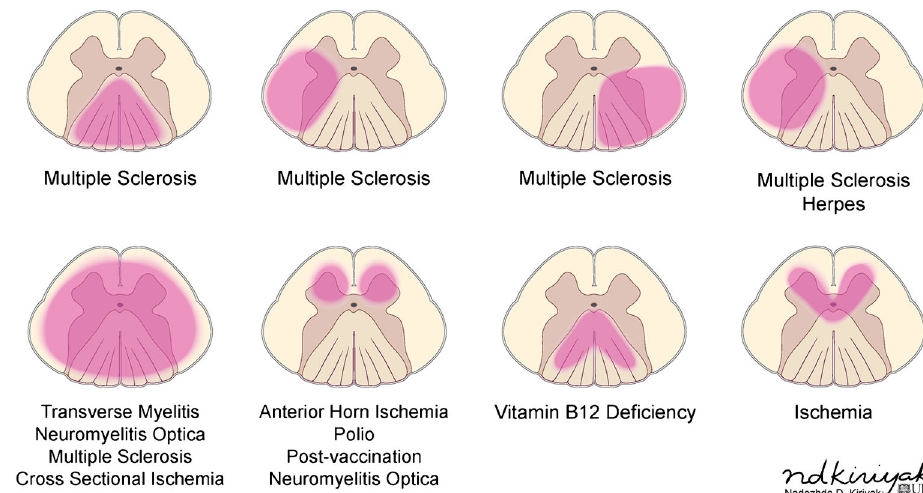
Fig. 2 Differentiating intramedullary pathology: location within the